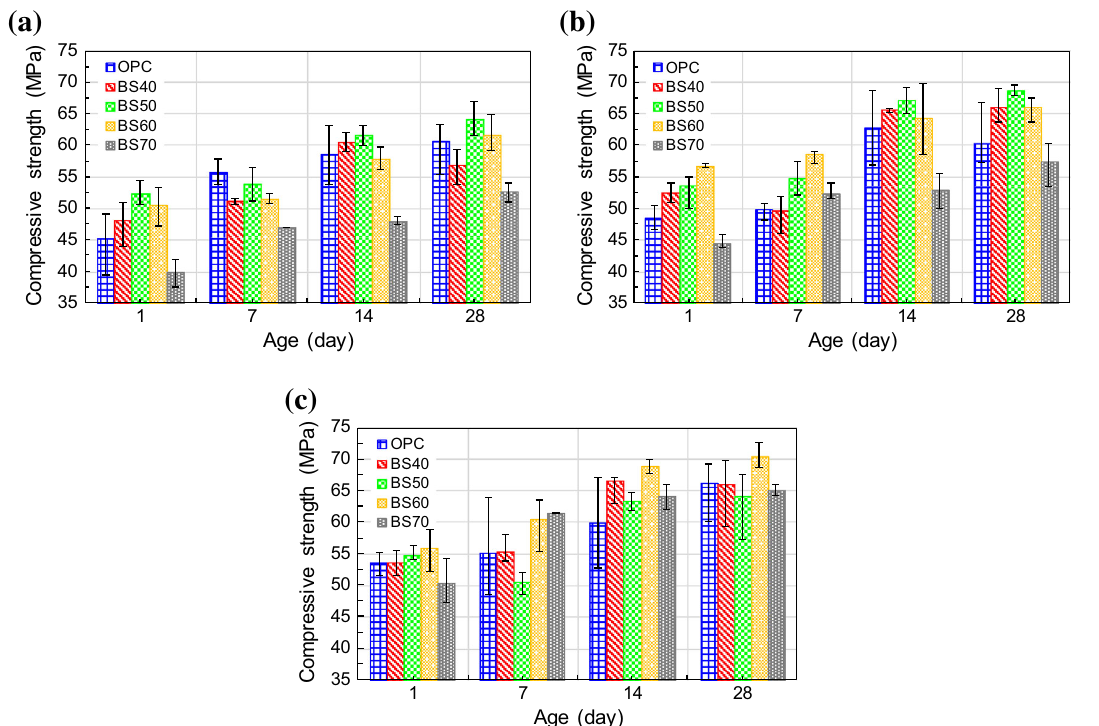
Fig. 5 Summary of compressive strength; a W/B of 0.3, b W/B of 0.275, c W/B of 0.25.